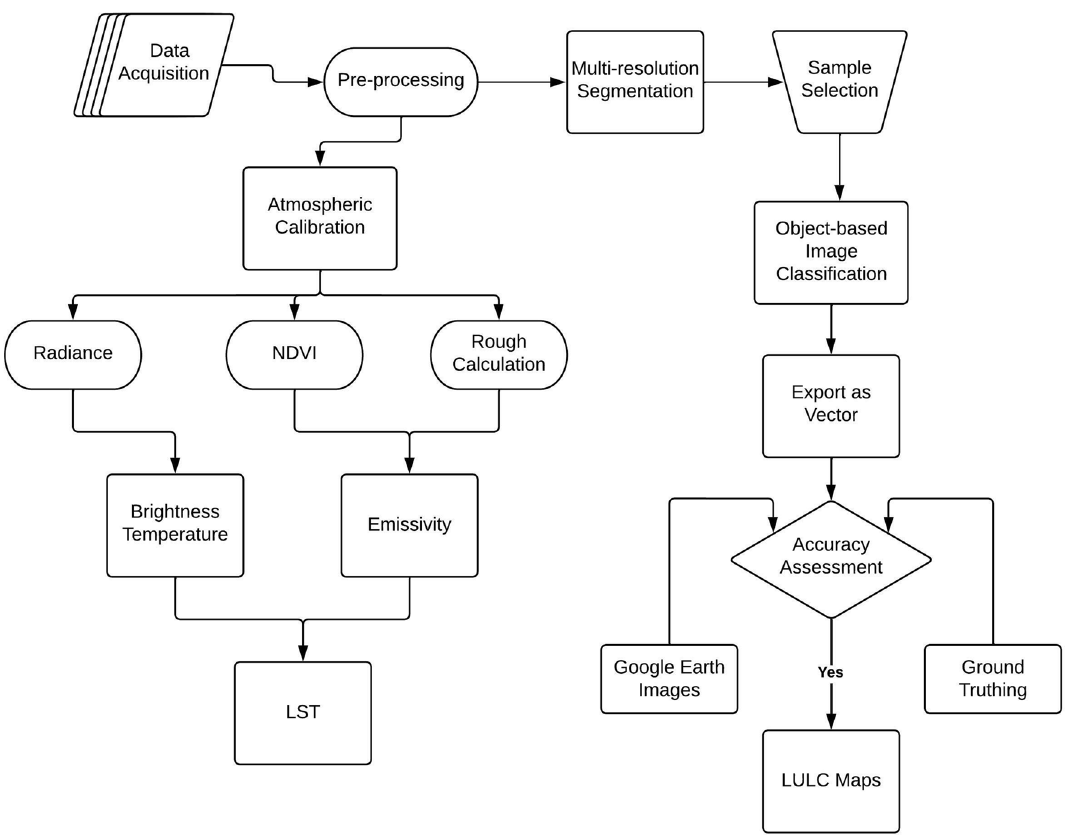
Fig. 2 Flow chart illustrating various methods to produce LULC maps from multi-temporal satellite